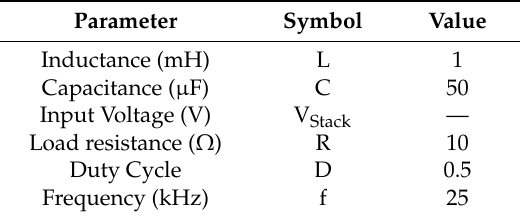
Table 2. Boost Converter